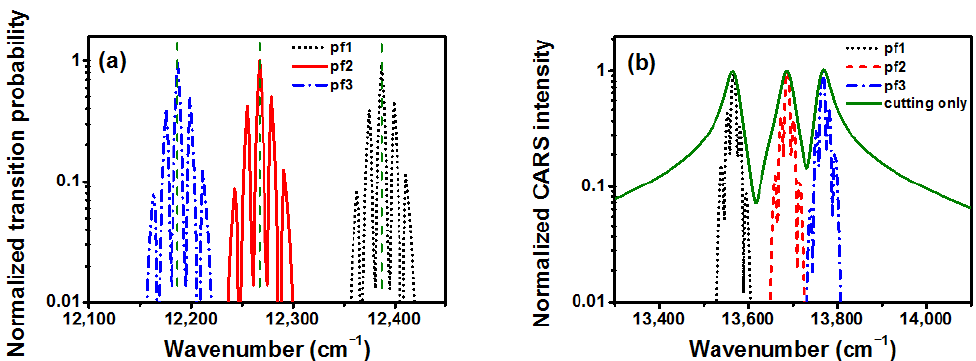
Figure 4. ( a ) Normalized stimulated Raman transition probabilities and ( b ) CARS intensities. The green dotted lines in ( a ) represent different step positions where the corresponding Raman peak is selectively excited. The green solid line represents the CARS intensities obtained only by cutting off the probe spectrum as shown in ( b ).